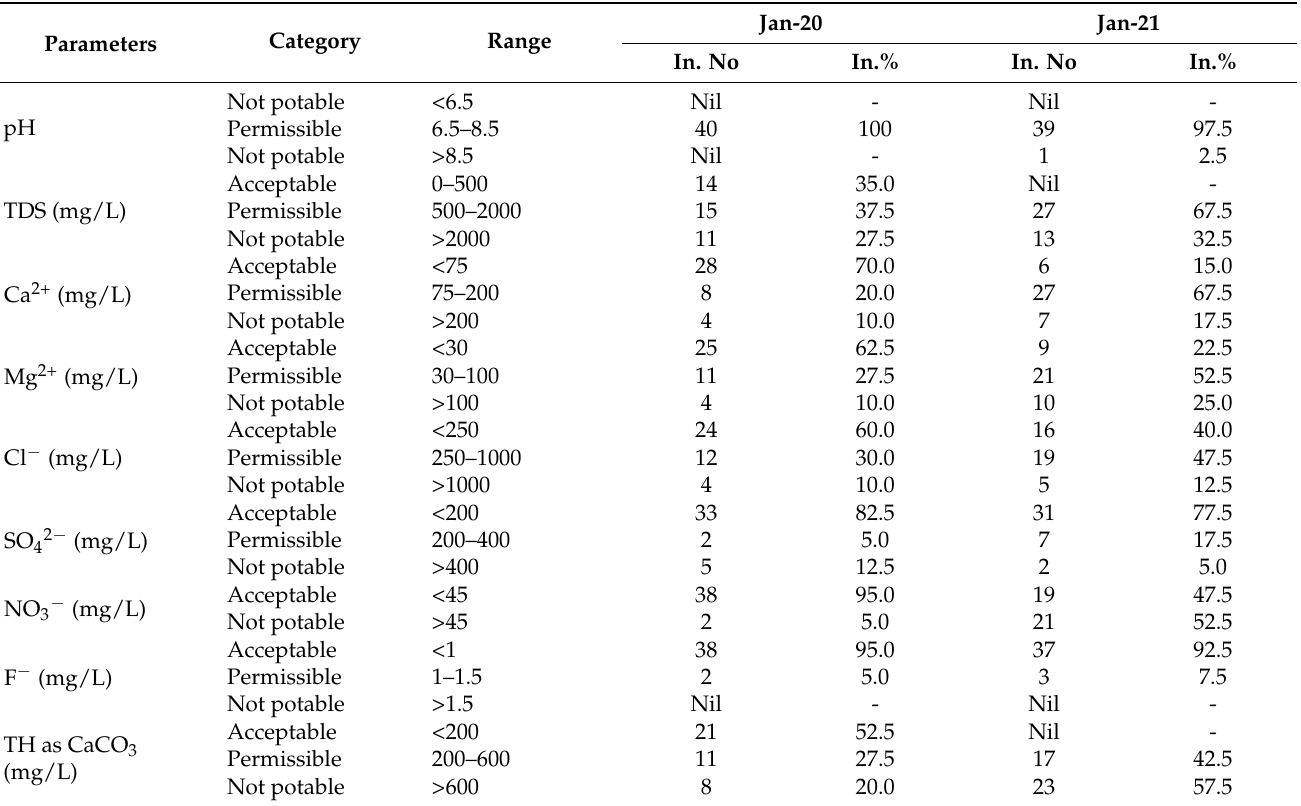
Table 2. WHO [31] and BIS [54]-based potable water